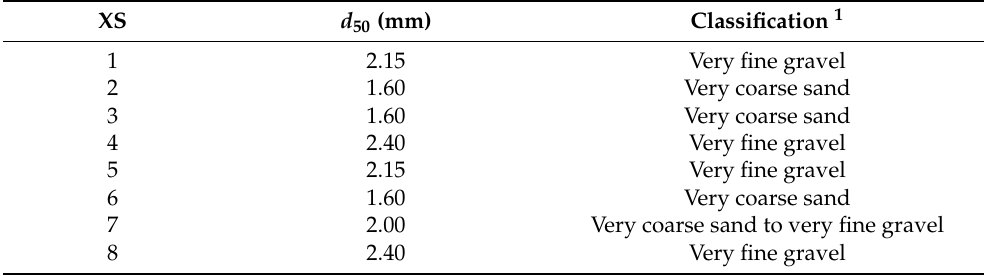
Table 1. Median grain size ( d 50 ) and classification of the bed material at the chosen cross-section.